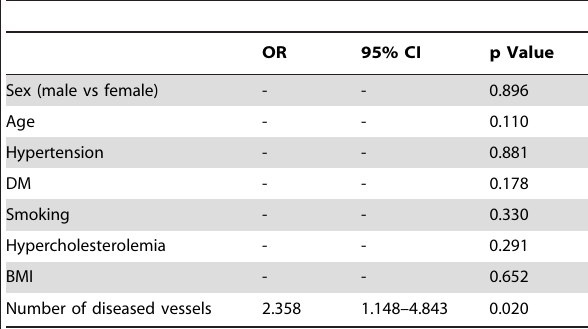
Table 3. Multivariate logistic regression analysis of